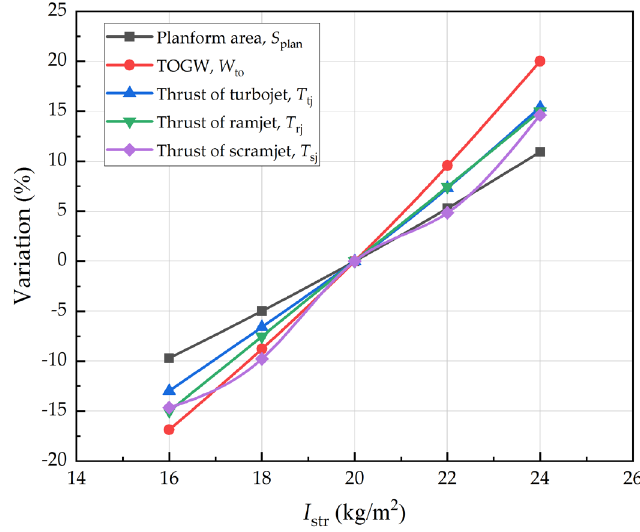
Figure 11. Impacts of the structural index ( I str ) on weight, size, and thrust.